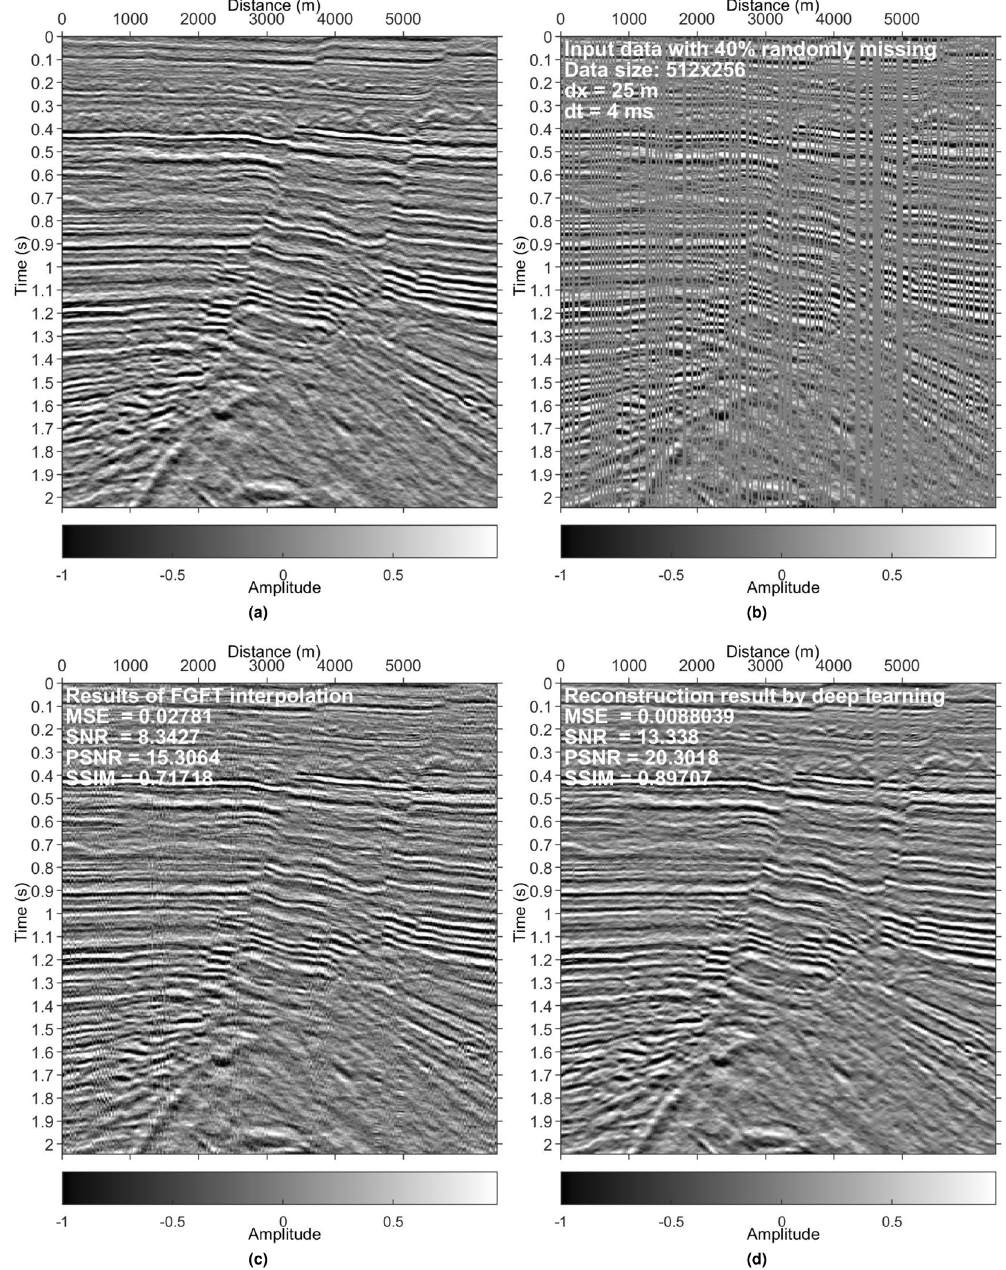
Figure 10. Results on a data set from the GeoFrame software. ( a ) Reference data. ( b ) Irregularly sampled data with 40% missing. ( c ) Interpolated data using the FGFT interpolation method 23 . ( d ) DL reconstruction